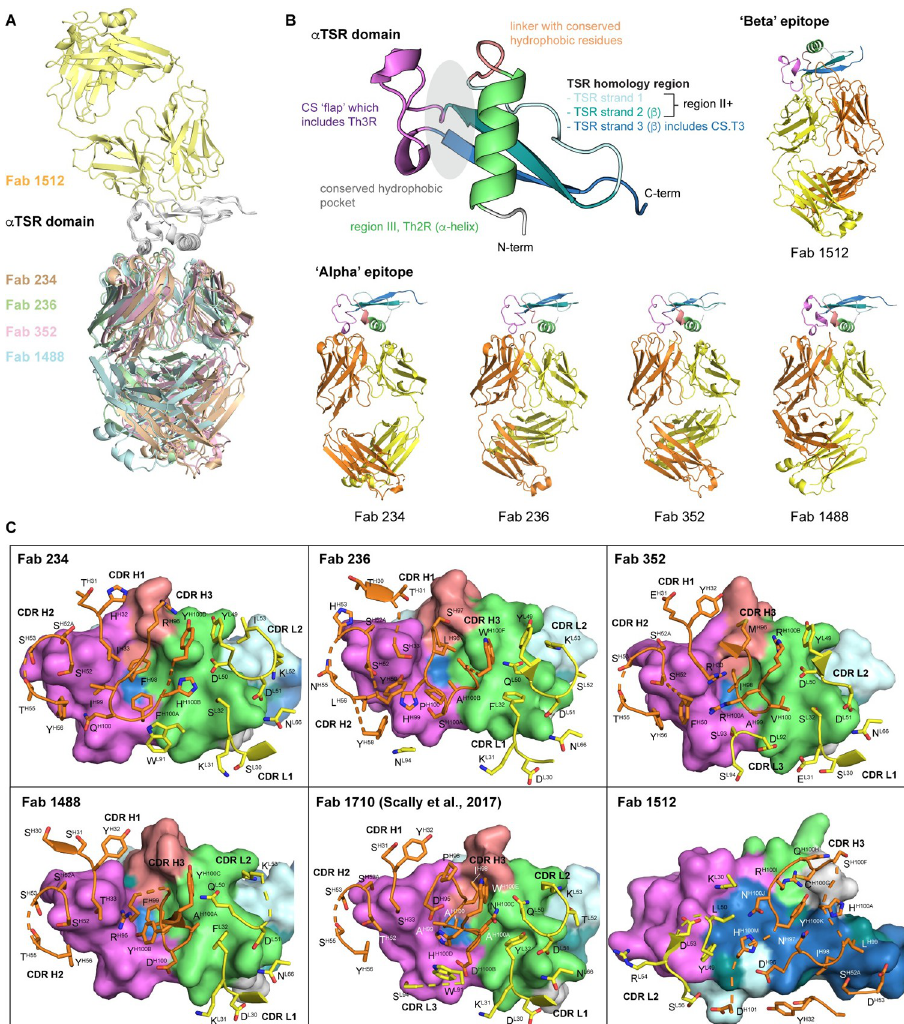
Fig 2. Crystal structures of anti-ctCSP Fabs in complex with the α TSR domain. ( A ) Alignment of Fab234, 236, 352, 1488, and 1512 complexes (colored as shown) interacting with the α TSR domain (grey). The complexes are shown in ribbon cartoon representation. ( B ) Ribbon representation of the α TSR domain with important regions labeled and colored. The epitopes on the α TSR domain can be classified into: 1) the α -epitope region recognized by Fabs 234, 236, 352, and 1488; and 2) the β -epitope region recognized by Fab 1512. The Fab heavy chain and light chain are colored orange and yellow, respectively. ( C ) The epitopes of the Fabs are represented as surfaces and colored based on the different regions on the α TSR domain as in ( B ). The paratopes are shown as cartoons with side chains as sticks. The heavy chain and light chain are colored as in ( B ).